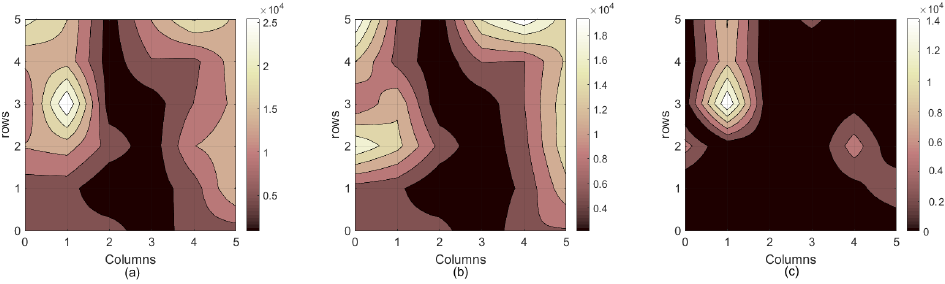
Figure 17. 2D mapping of electrical resistivity due to changes in soil compaction: ( a ) ρ a before, ( b ) ρ a after, and ( c ) difference between ρ a after and ρ a before.